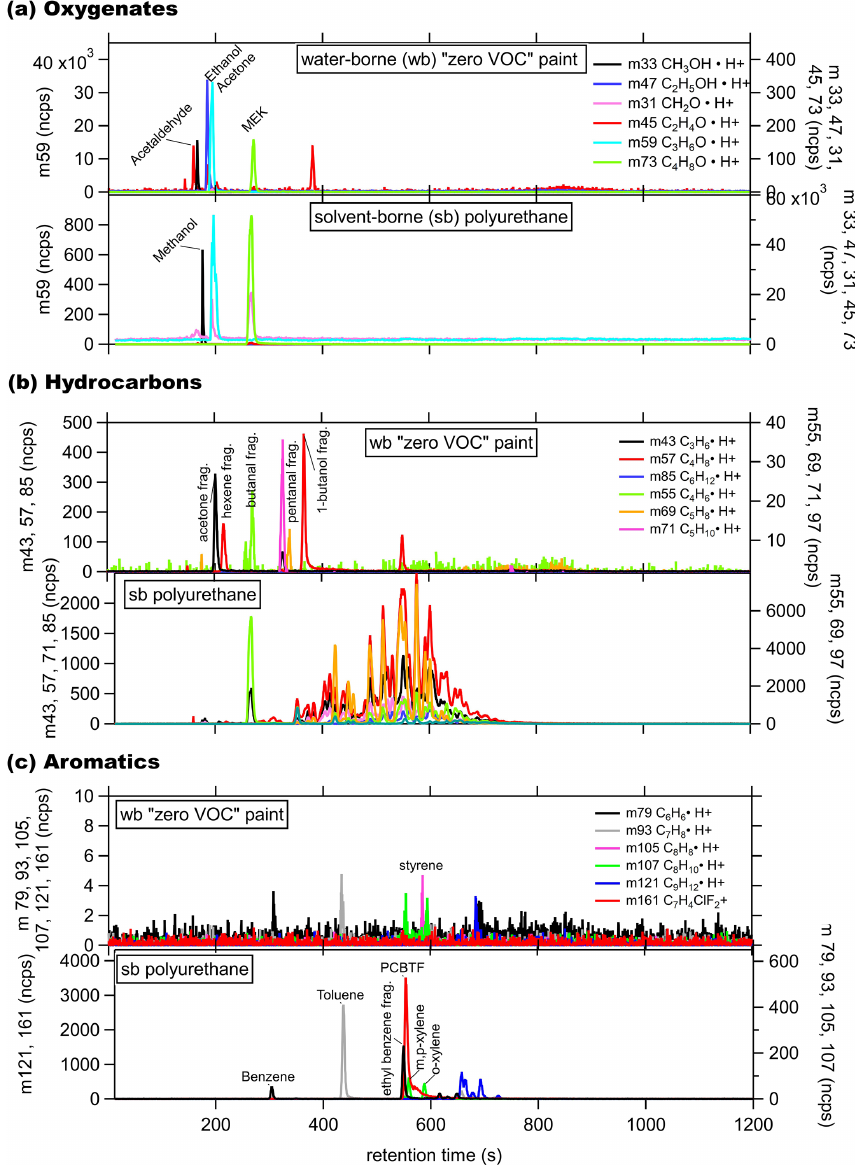
Figure 4. GC-PTR-ToF chromatogram from the headspace of a water-borne (wb), “zero VOC” low-odor paint with ink and a solvent-borne (sb) polyurethane stain for (a) small oxygenates, (b) hydrocarbons, and (c)